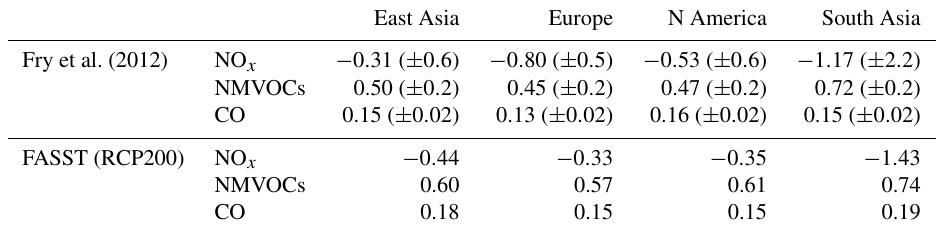
Table 12. Regional-to-global direct radiative forcing efficiencies for O 3 precursors (mWm − 2 Tg − 1 of annual emissions) for the larger source–receptor regions in earlier work, and from FASST, aggregated to similar regional definitions, including direct O 3 forcing, feedbacks on CH 4 and long-term O 3 forcing from the latter. Values in brackets represent reported 1SD from the model ensemble in Fry et al. (2012). East Asia